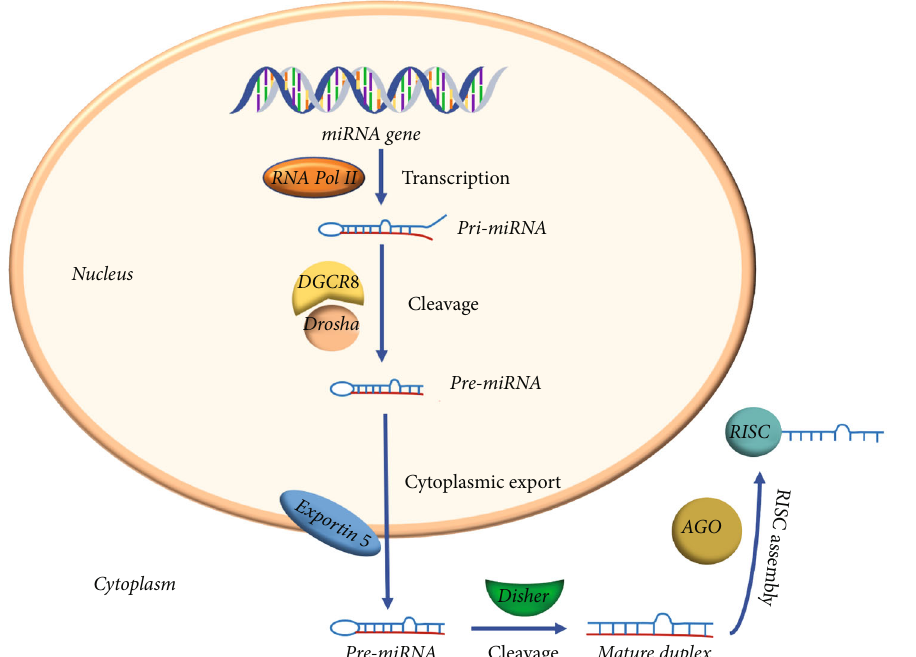
Figure 1: Overview of the miRNA